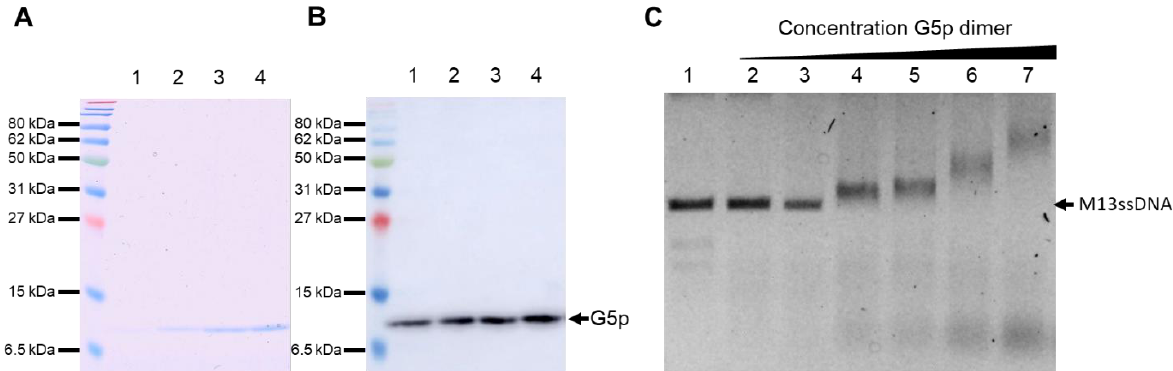
Figure 6. Affinity purification of the DNA-binding protein G5p. The elution fractions (lanes 1 to 4) were visualized with Coomassie staining ( A ) and on a Western blot with a his tag antibody ( B ). The purified G5p was incubated with purified M13-ssDNA and analysed with EMSA ( C ). Lanes 1 to 8 contained 200 ng of M13-ssDNA. Increasing amounts of G5p were added; in lane 2: 15 ng, lane 3: 80 ng, lane 4: 130 ng, lane 5: 160 ng, lane 6: 480 ng and lane 7: 800 ng.